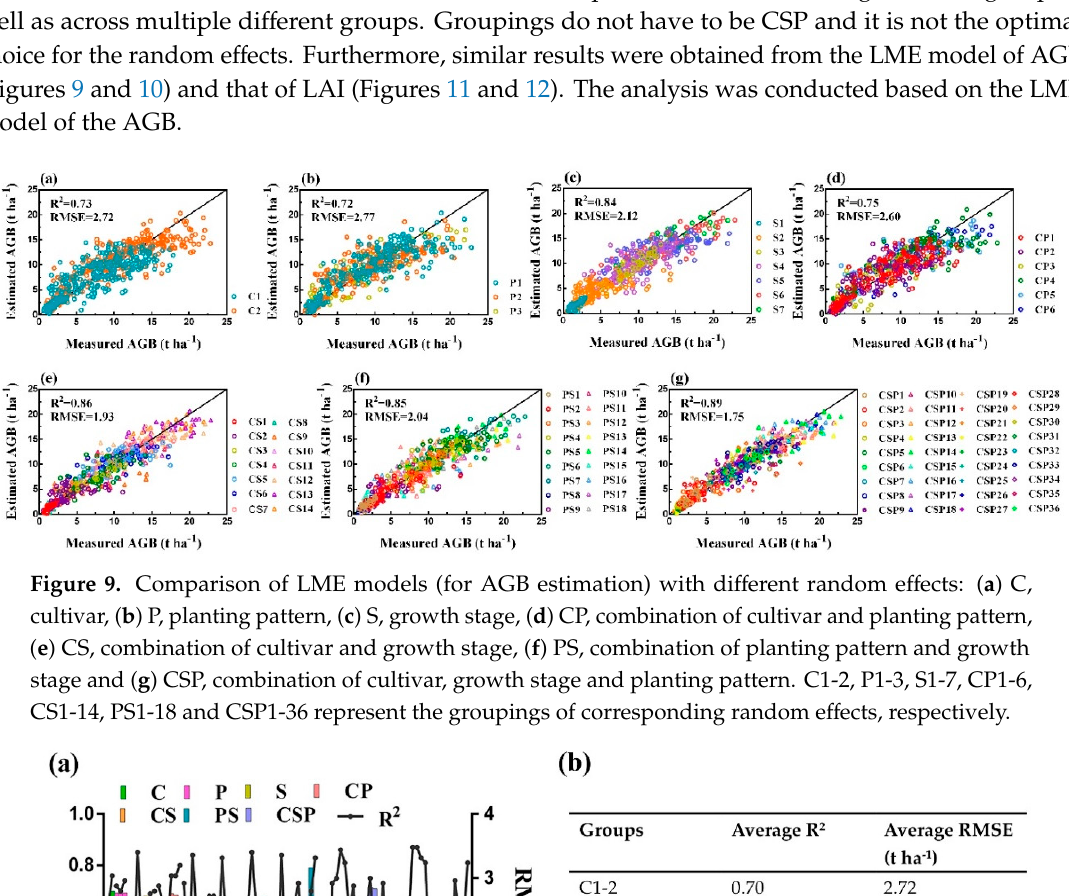
Figure 11. Comparison of LME models (for LAI estimation) with different random effects: ( a ) C, cultivar, ( b ) P, planting pattern, ( c ) S, growth stage, ( d ) CP, combination of cultivar and planting pattern, ( e ) CS, combination of cultivar and growth stage, ( f ) PS, combination of planting pattern and growth stage and ( g ) CSP, combination of cultivar, growth stage and planting pattern. C1-2, P1-3, S1- 7, CP1-6, CS1-14, PS1-18 and CSP1-36 represent the groupings of corresponding random effects, respectively.